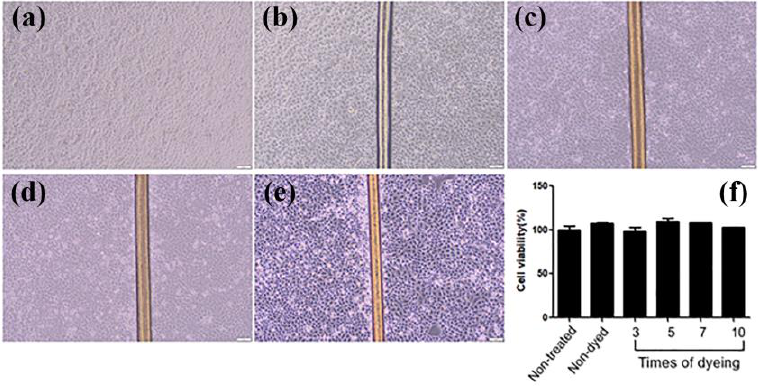
Figure 7. ( a – e ) The effects of dyed hair on human-keratinocyte-growth microscopic analysis, and ( f ) MTT assay of human keratinocytes co-cultured with hair for 24 h (magnification × 20).